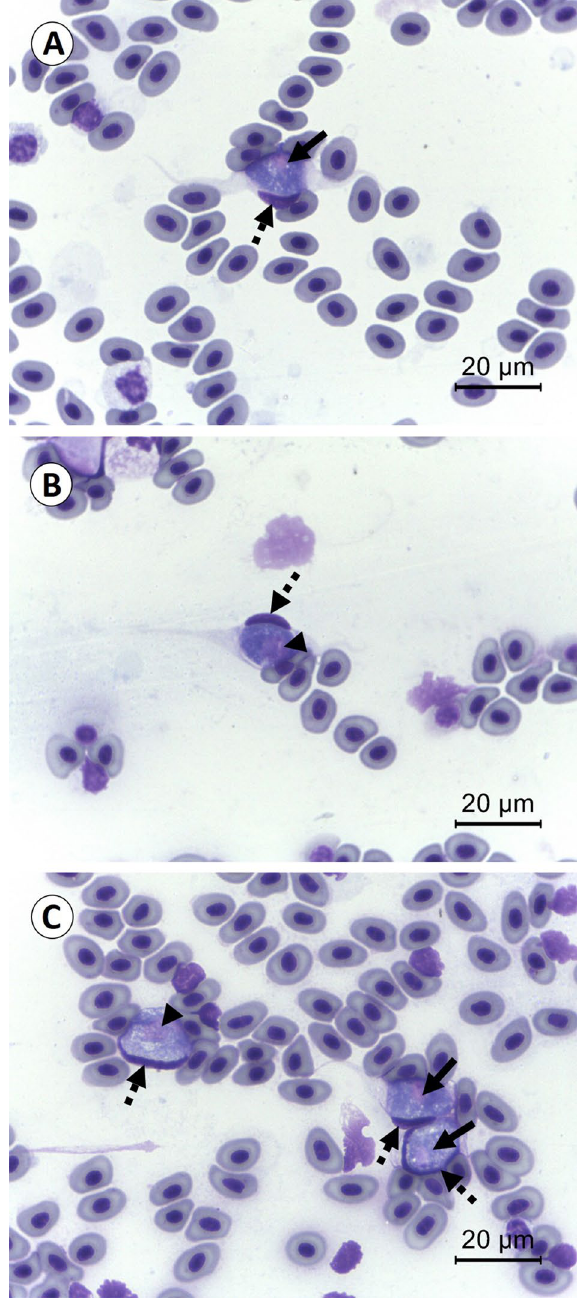
Figure 1. Gametocytes of L. sabrazesi in chicken’s cells identified from Geimsa stained blood smear. The high magnification micrographs showed the elongated macrogametocytes ( A ), elongated microgametocytes ( B ) and rounded microgametocyte (the left side) and rounded and elongated macrogametocytes (the right side) ( C ). The arrows present parasites’ nuclei of macrogametocytes. The arrowheads indicate parasites’ nuclei of microgametocytes. The dashed arrows demonstrate hosts’